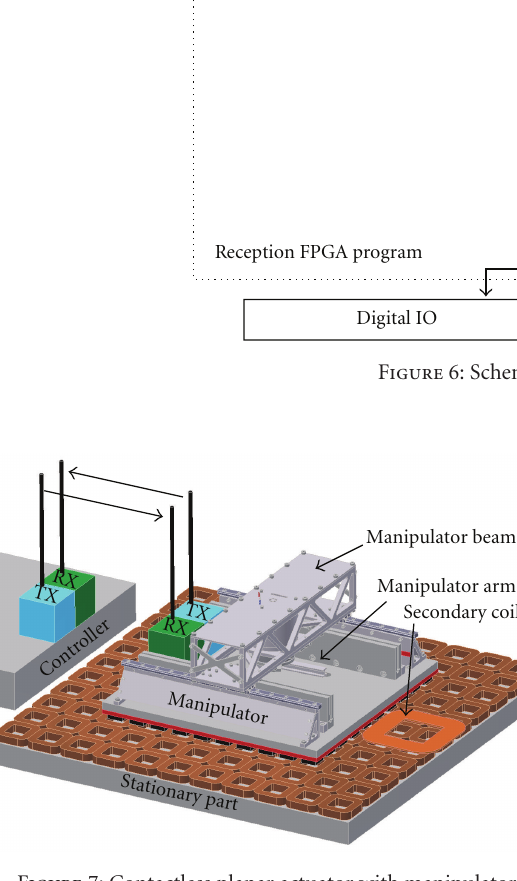
Figure 7: Contactless planar actuator with manipulator.